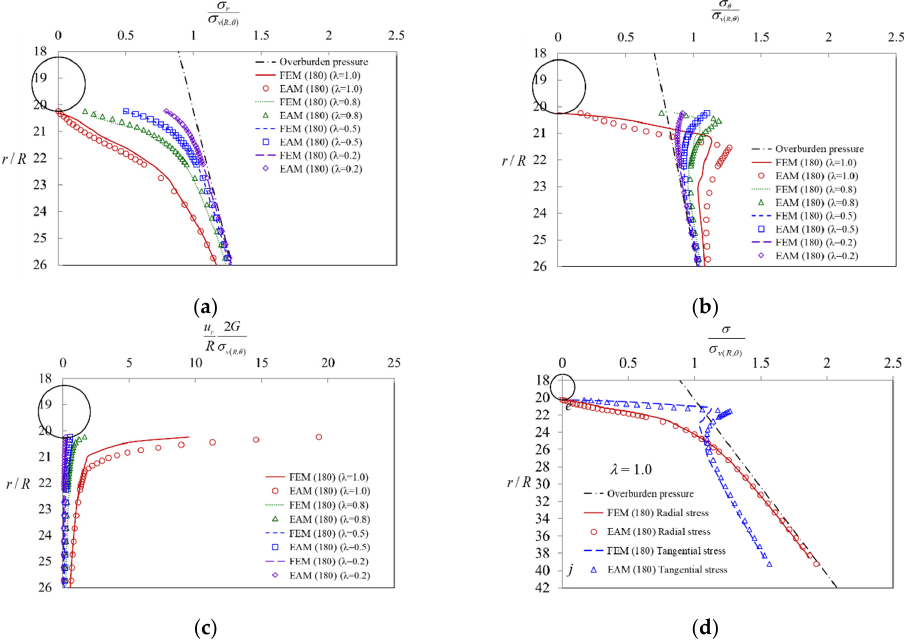
Figure 17. Ground reaction around the tunnel obtained by EAM and FEM with the different incre- mental values λ in an elastoplastic media, and the distribution of ( a ) radial stress, ( b ) tangential stress, ( c ) radial displacement, and ( d ) tangential and radial stresses with λ = 1.0 (Case III, θ = 180°, along the deep line and K o = 0.8).